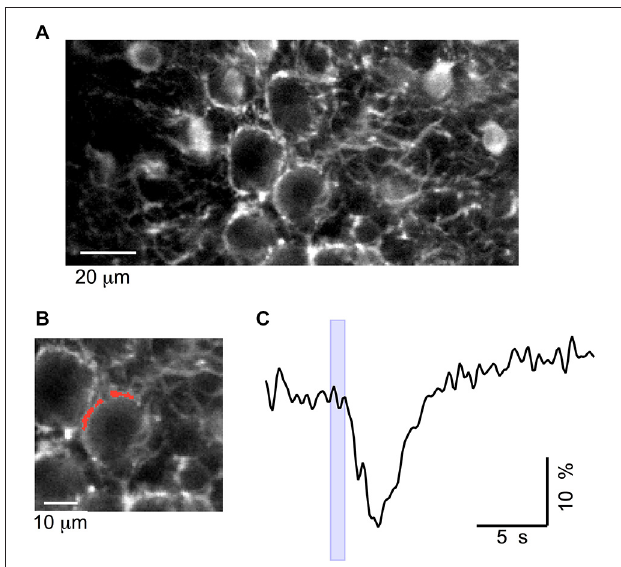
FIGURE 8 | Muscimol silencing of basket terminals in vivo . (A) Two-photon image of the cerebellar cortex at the depth of 150–200 µ m. (B) Zoom of the image in (A) , with the analyzed ROI depicted in red. (C) Time course of the change in fluorescence elicited by muscimol, at the time indicated by the blue box, with the iontophoresis pipette placed in front of the terminal.